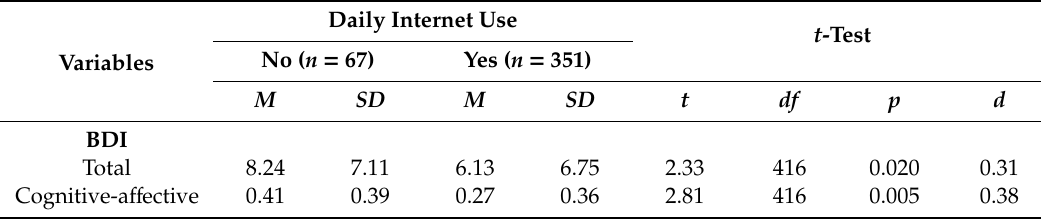
Table 14. Significant means di ff erences of dependent variables in relation to hours of Internet use. Hours Per Day of Internet Use Variables